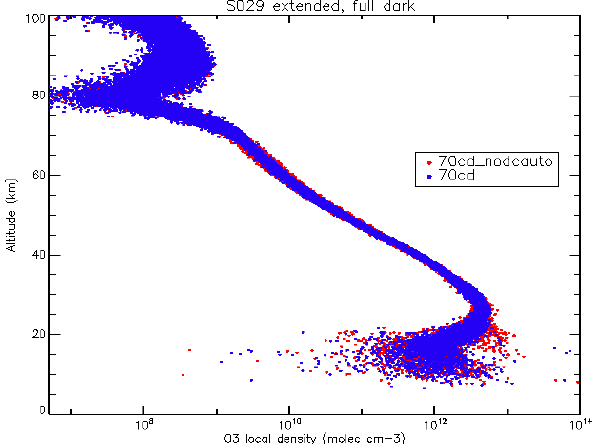
Fig. 6. O 3 line density profiles retrieved from occultations of one star with a favourable spectrum and luminosity conditions for dark background conditions processed with the GOPR v6.0cf algorithm including DSA dark charge estimate (red) and GOPR v7.0ab pro- cessing including background bands to better estimate the Dark Charge of the central band